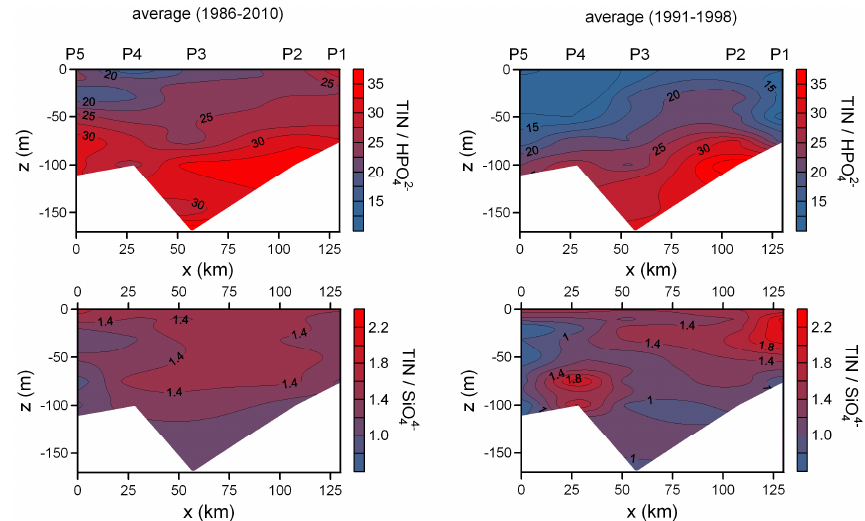
Fig. 9. Palagruˇza Sill profiles of TIN to HPO 2 − and TIN to SiO 4 − ratios averaged over common period of measurements 1986–2010 (left 4 4 panels) and over 1991–1998 (right Figure 9. Palagruža Sill profiles of TIN to HPO 42- and TIN to SiO 44- ratios averaged over common period of measurements (1986-2010, left panels) and over 1991-1998 (right panels).